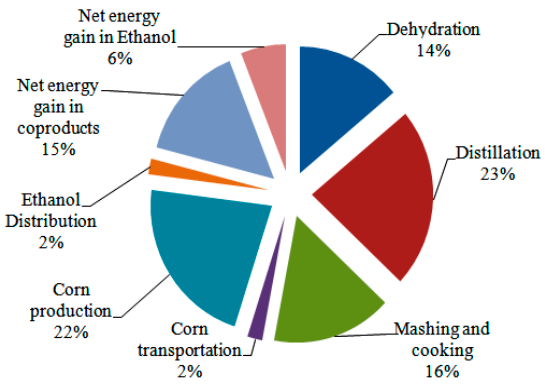
Figure 1. Net energy balance for various stages of corn ethanol manufacture [5,6].